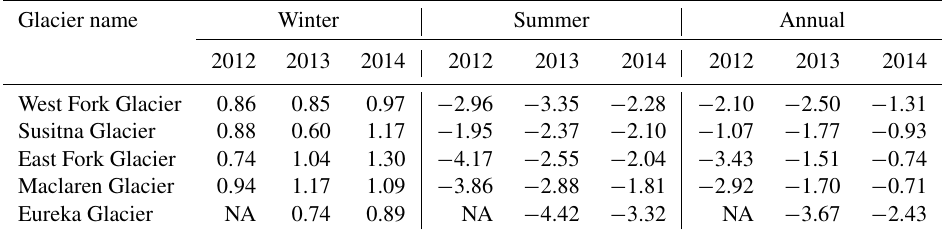
Table 5. Glacier-wide winter, summer, and annual mass balance (mw.e.) on the five largest glaciers in the Upper Susitna basin, 2012–2014. Mass balances were measured during site visits in the following date ranges: 26 April to 2 May 2012, 26–28 September, 15–21 April, 6– 15 September 2013, 22–27 April, and 7–9 September 2014. Exact dates for individual stake measurements are listed in the data set. NA denotes no data were